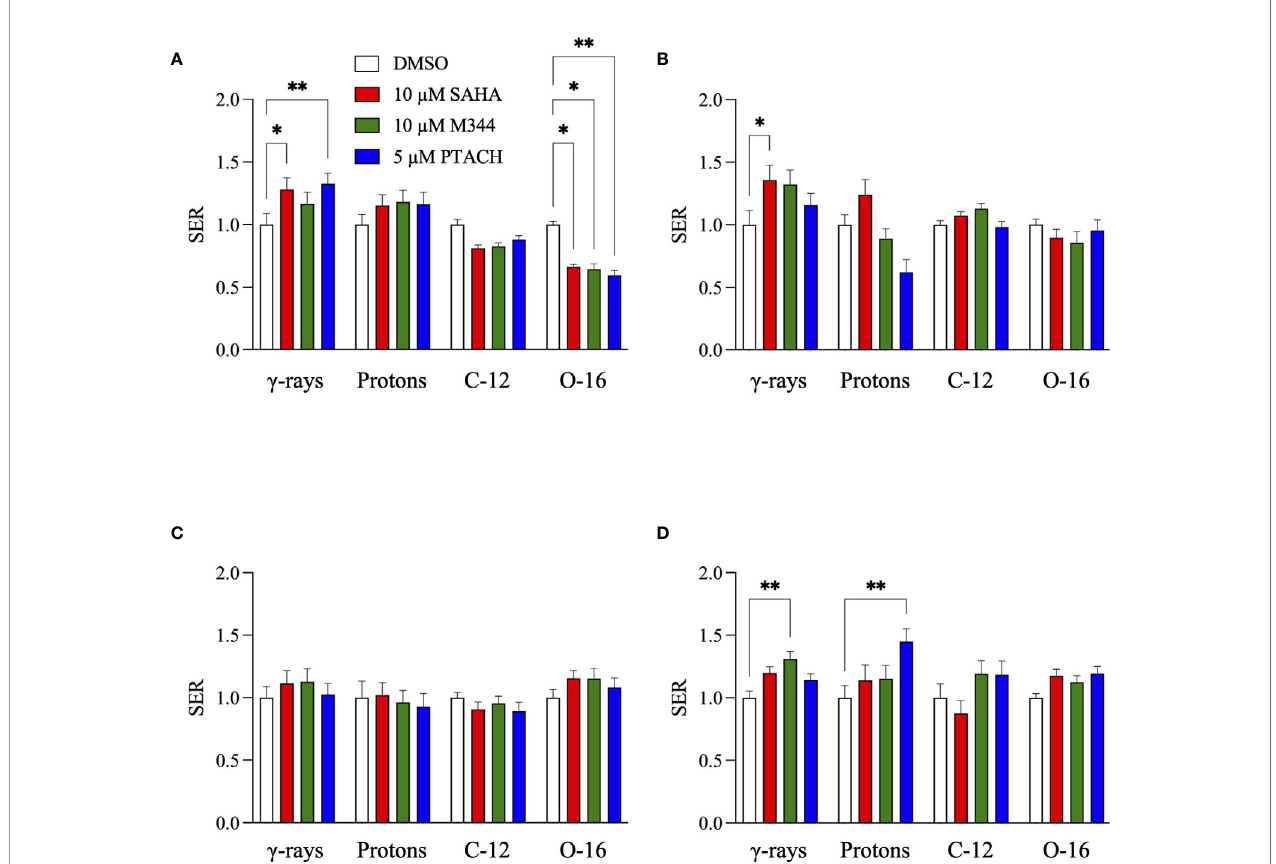
FIGURE 5 | HDACi sensitizer enhancement ratio (SER) values ± SEM for G0/G1-phase normal NFF28 primary fi broblasts (A) and asynchronously growing A549 lung carcinoma (B) , U2OS osteosarcoma (C) , and U87MG malignant glioma cells (D) pretreated for 18 h with 10 µM SAHA, 10 µM M344, and 5 µM PTACH and irradiated with cesium-137 g -rays, 200 MeV protons, 290 MeV/n C-12 ions, or 350 MeV/n O-16 ions [calculated using D 10 survival values; asterisks mark signi fi cant differences at p -values of ≤ 0.05 (*) and ≤ 0.01 (**) by two-way